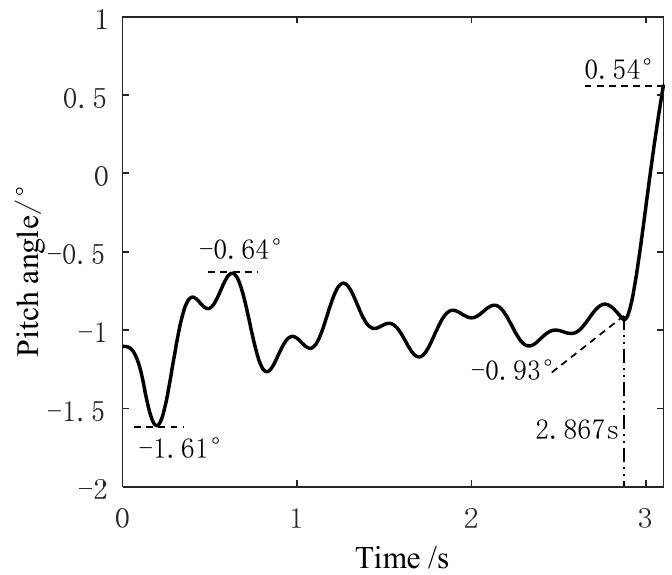
Figure 11. Time versus pitch angle of carrier-based aircraft.